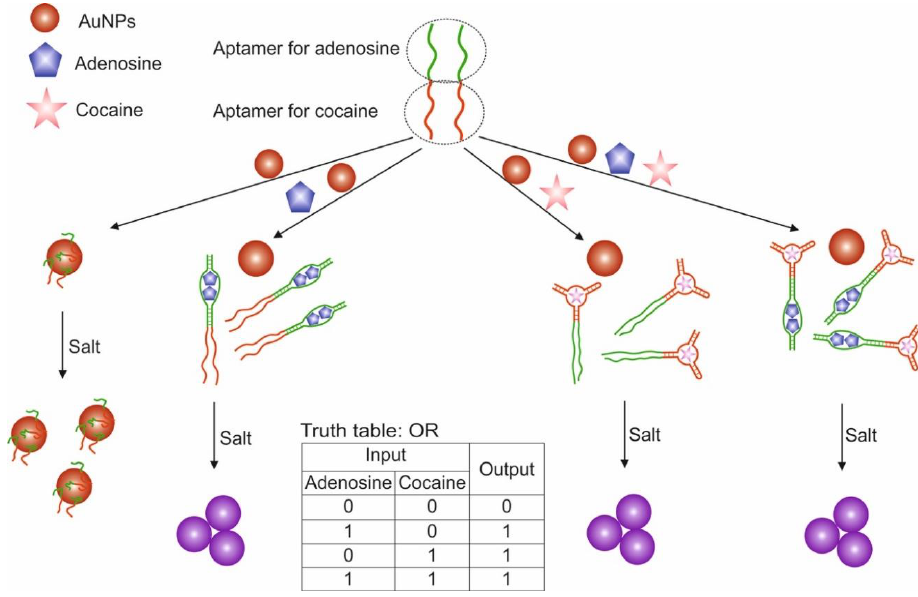
Figure 7. The OR logic gate. Adapted from Reference [55] by permission of The Royal Society of Chemistry.